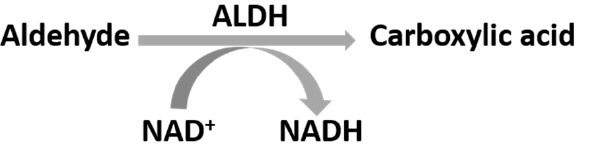
Table 1. Comparison among several methods for the determination of thiram.